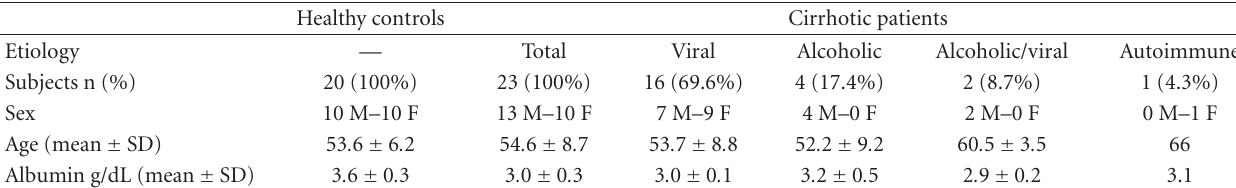
Table 1: Demographic and clinical characteristics of cirrhotic patients and healthy controls.